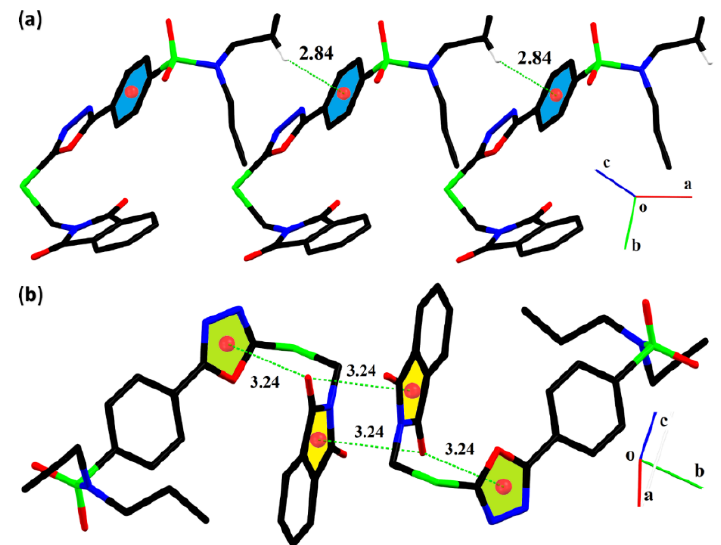
Figure 5. Representation for ( a ) C-H · · · π interactions that form an infinite chain of molecules besides the a-axis, ( b ) C-O · · · π interactions that interlink molecules through a dimeric form. Distances are in Å.